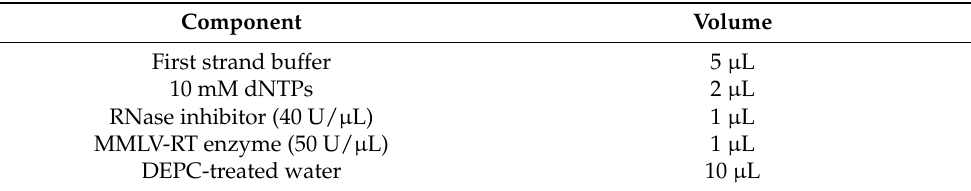
Table 1. Composition of cDNA master mix.